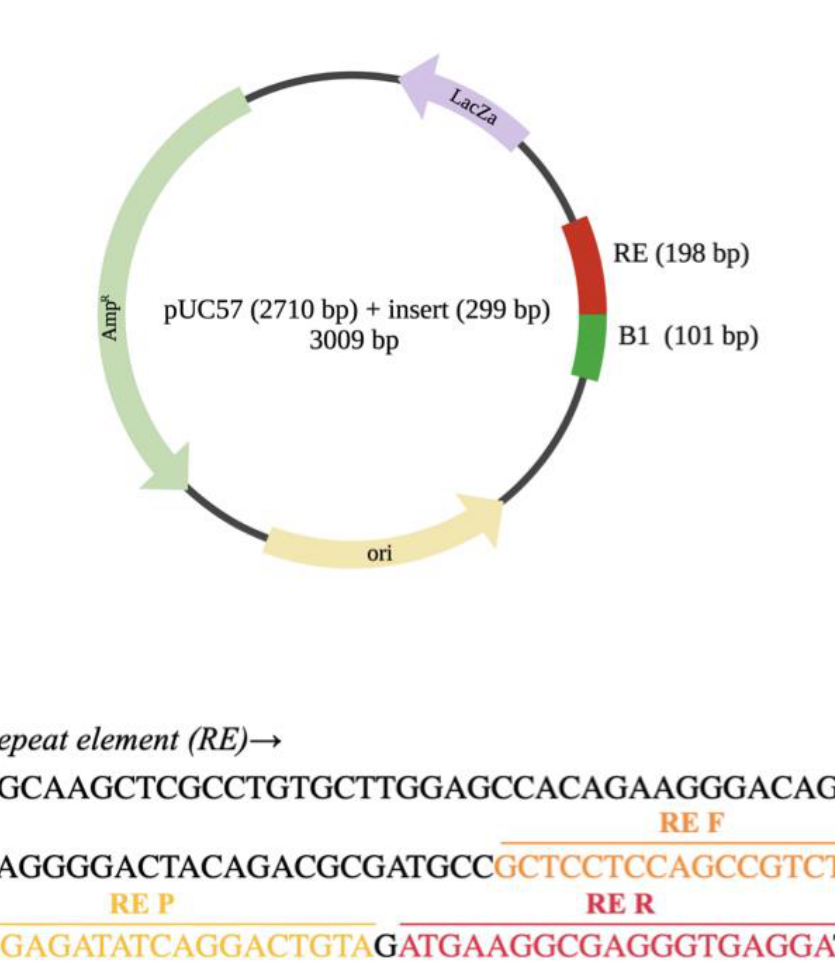
Figure 6. ( A ): The map of synthetic spike-in standard; ( B ): The sequence of synthetic spike-in standard. The sequences were based on the partial sequence of RE and B1 genes. DNA sequences used for primer and probe design are shown by heavy lines.